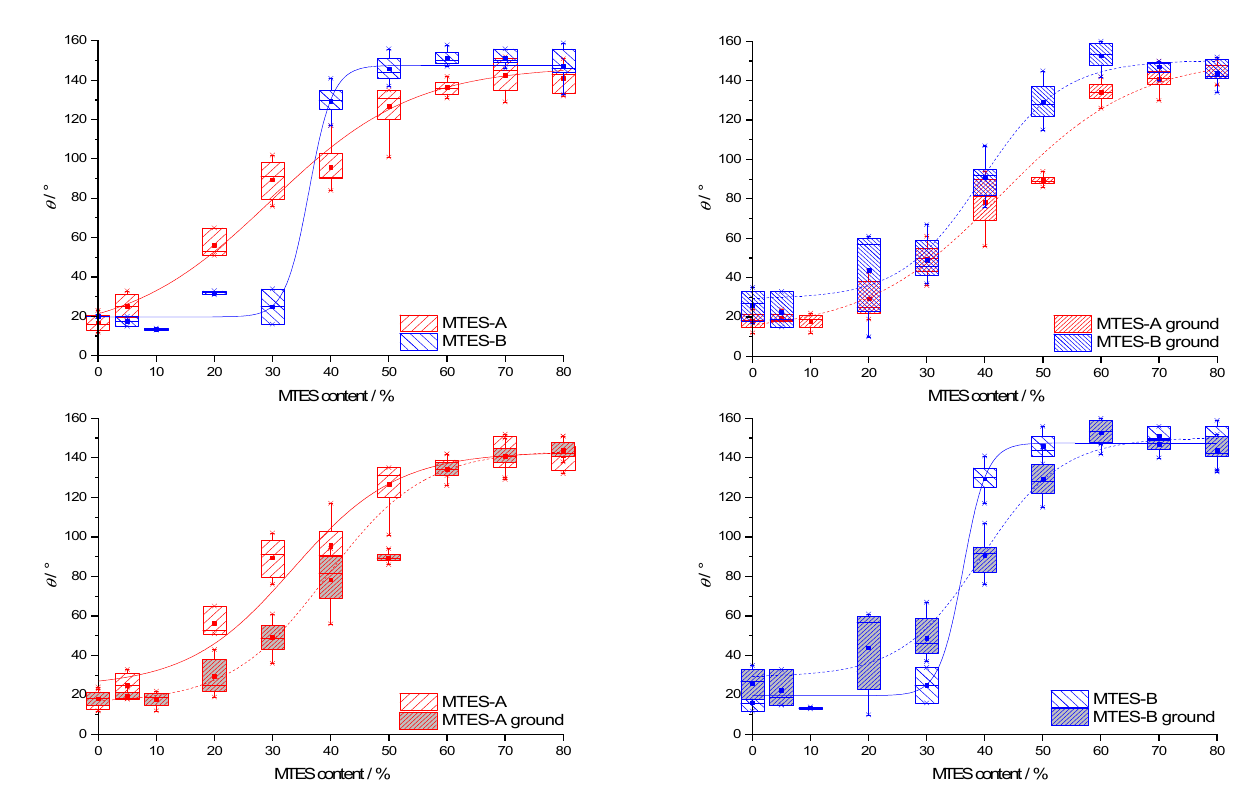
Figure 10. Box plot statistical representation of the advancing contact angles of MTES samples, series A and B, both as-received and ground, in function of the methyl content, grouped in pairs in order to facilitate comparison (series A and series B labels represent the pH = 2.0 and pH = 4.5).